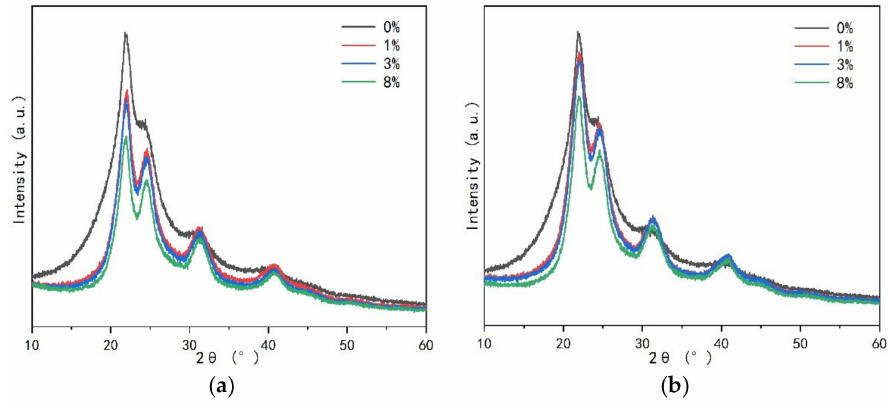
Figure 3. XRD pattern of UF resin with F/U = 1.0 under the influence of different content of curing agent. ( a ) NH 4 Cl, ( b ) AlCl 3